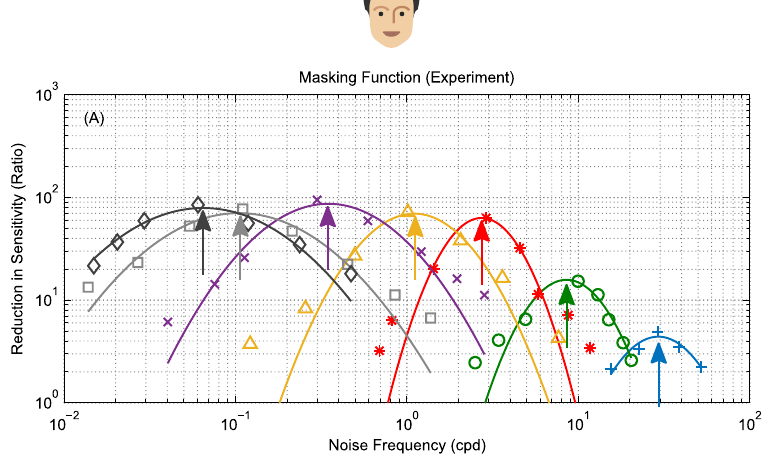
Figure 3. Effect of noise on mammalian motion detectors. Measurements showing the effect of noise on motion detection sensitivity in humans (reproduced from Fig. 1b from ref. 5). The colored points show responses to different signal frequencies (marked by arrows); smooth curves represent masking functions drawn through the symbols by eye 5 . Noise is most effective at masking the signal when its frequency is the same and less effective as its frequency changes in either